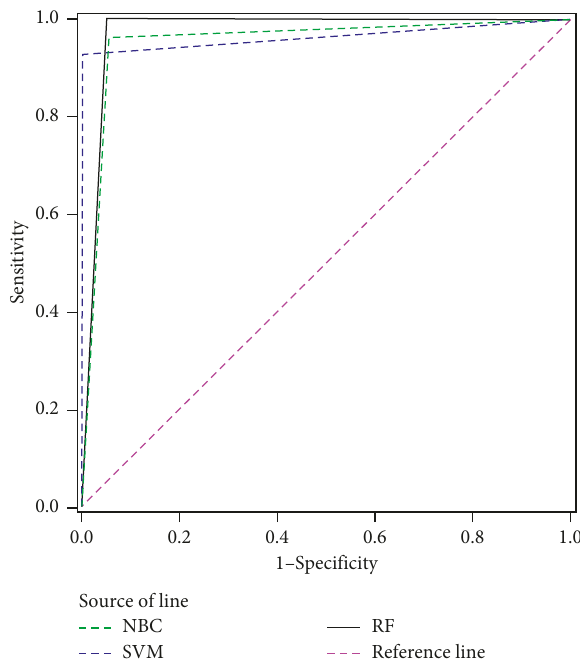
Figure 9: ROC of established RF, SVM (RBF), SVM (liner), and NBC models. The maximum area indicates the best predictive power